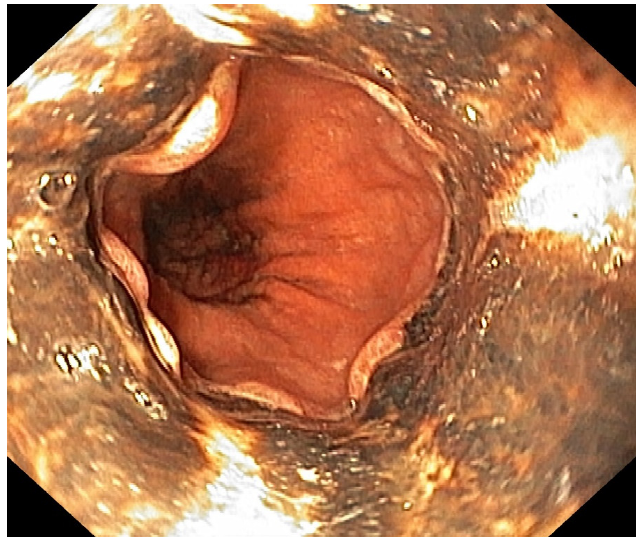
Figure 2. Black appearing mucosa of the esophagus that abruptly stops at the gastroesophageal junction. Five days later, the patient developed coffee ground emesis and the hemoglobin dropped from 9.3 g/dL to 8.8 g/dL. Upper endoscopy revealed a striking black appearance of two distal thirds of esophagus that abruptly stopped at the gastroesophageal junction, without other modifications (Figures 1 and 2). Treatment with PPI, Sucralfate, and parenteral nutrition were initiated while she was kept nil per os.